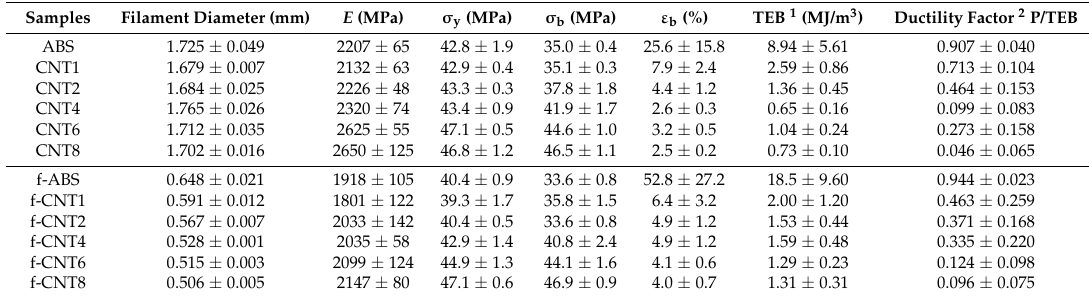
Table 5. Quasi-static tensile properties of ABS and its nanocomposite of filaments and single fiber (f) produced by twin screw and FDM extrusion, respectively.